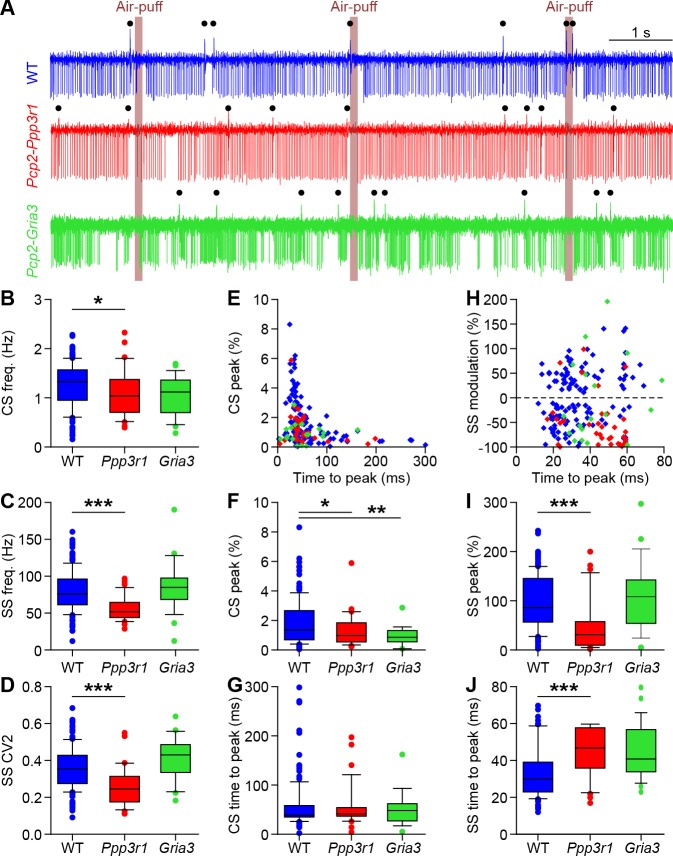
Purkinje cell responses to whisker pad stimulation in Pcp2-Ppp3r1 and Pcp2-Gria3 mice.(A) Example recordings of Purkinje cell activity in a wild-type (WT) (top), a Pcp2-Ppp3r1 deficient (middle) and a Pcp2-Gria3 deficient mouse (bottom). The timing of air-puffs to the whisker pad is indicated with light brown lines and that of the complex spikes with black dots above the traces. Compared to their WT littermates, Pcp2-Ppp3r1 mice had a mildly reduced complex spike rate (B), as well as fewer simple spikes (C) that on top were fired more regularly (lower CV2; D). In contrast, the Pcp2-Gria3 mice showed firing patterns that were more similar to their WT littermates. For clarity, the two WT groups are pooled for visualization, but statistics were performed between mutants and their respective control littermates. (E) Complex spike responses to air-puff stimulation were quite similar in the three groups, although the mutants tended to have lower peak responses (F) with normal timing (G). (H) Simple spike responses to air-puff stimulation were similar between WT and Pcp2-Gria3 mice, but Pcp2-Ppp3r1 mice showed more inhibition upon stimulation (I) with a longer latency (J). *p<0.05; **p<0.01; ***p<0.001. See also Supplementary file 1C and Source Data File.